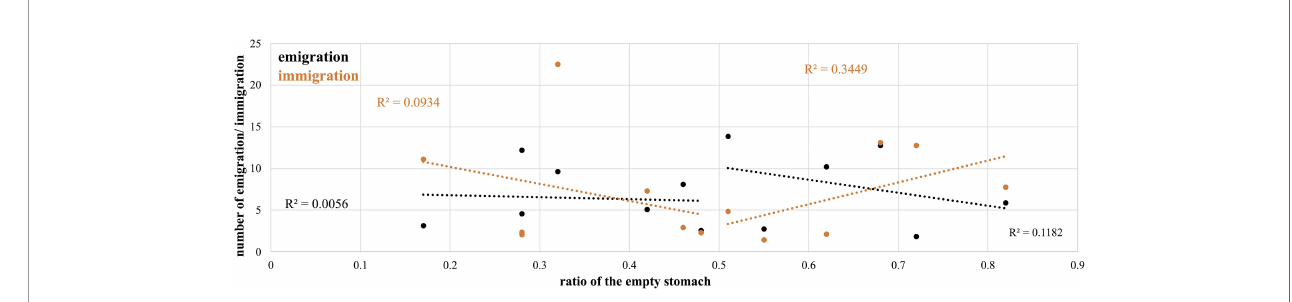
FIGURE 7 | The linear regression between emigrations and immigration and the ratio of the empty stomach in each Trichiurus japonicus